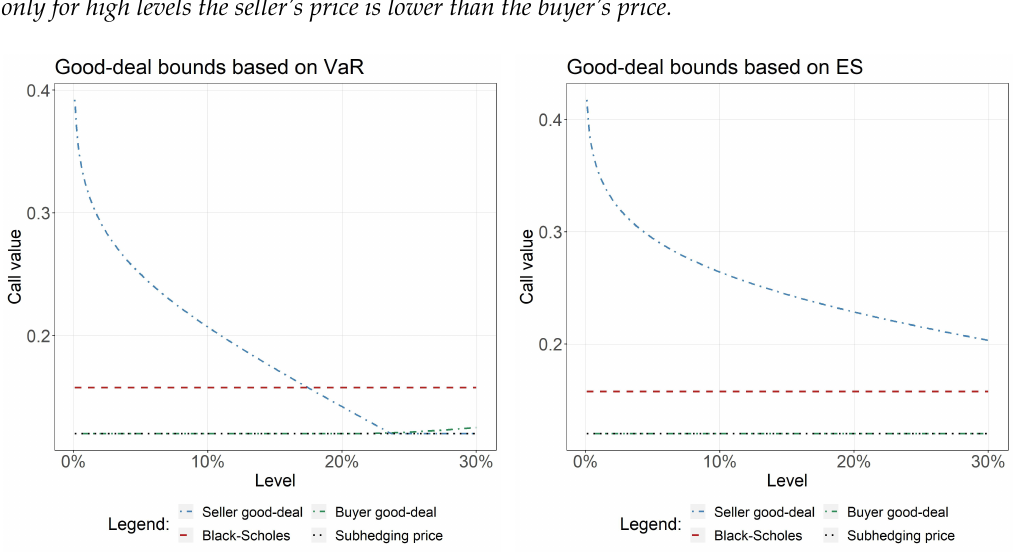
Figure 5. Good-deal bounds depending on the level λ